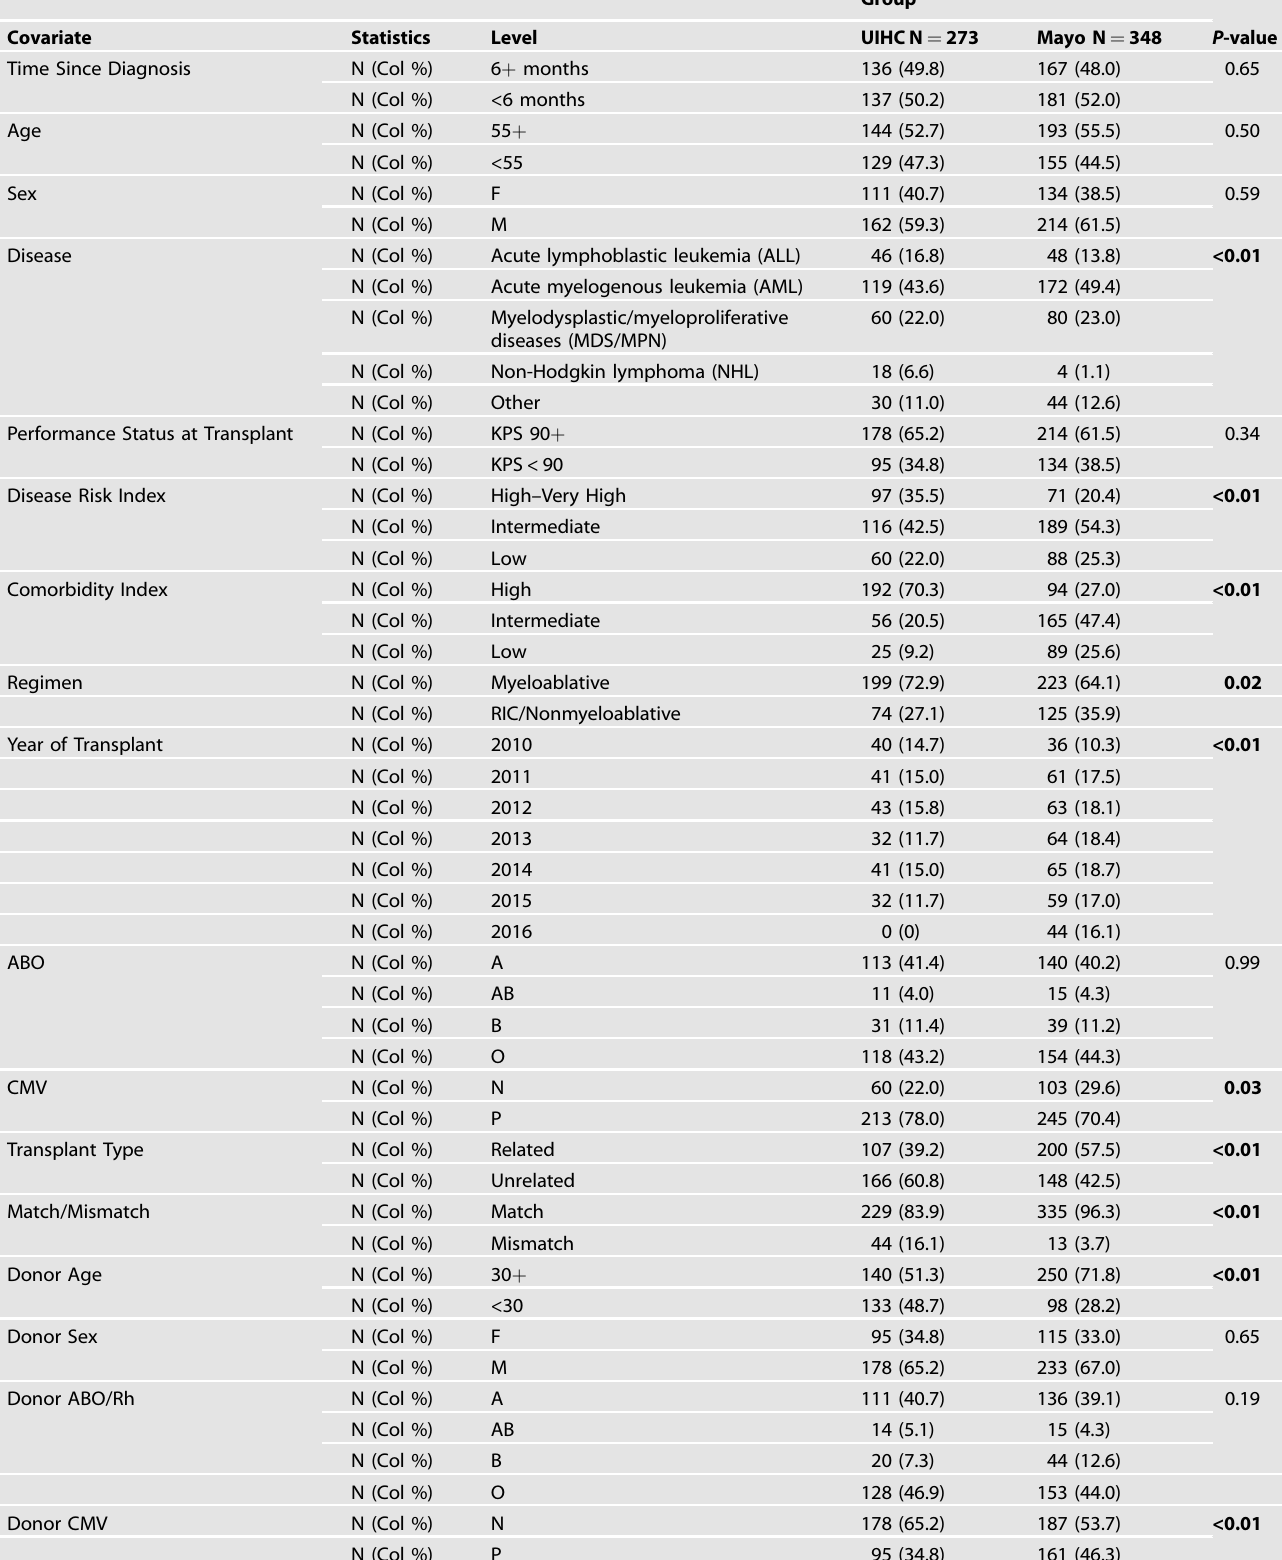
Table 1. Patient demographic and transplant characteristics of the two